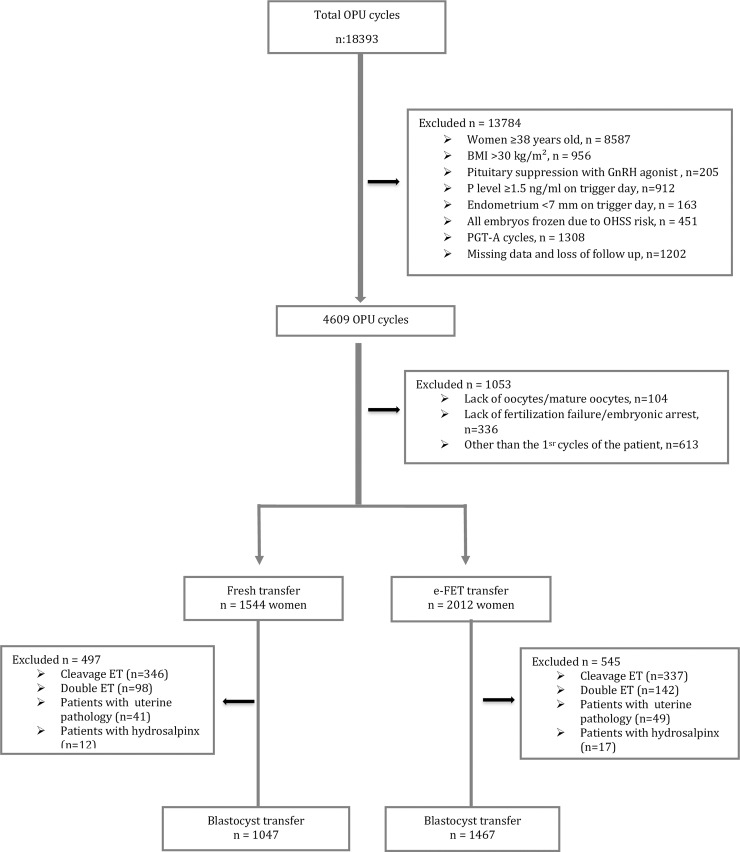
Flowchart of the study.